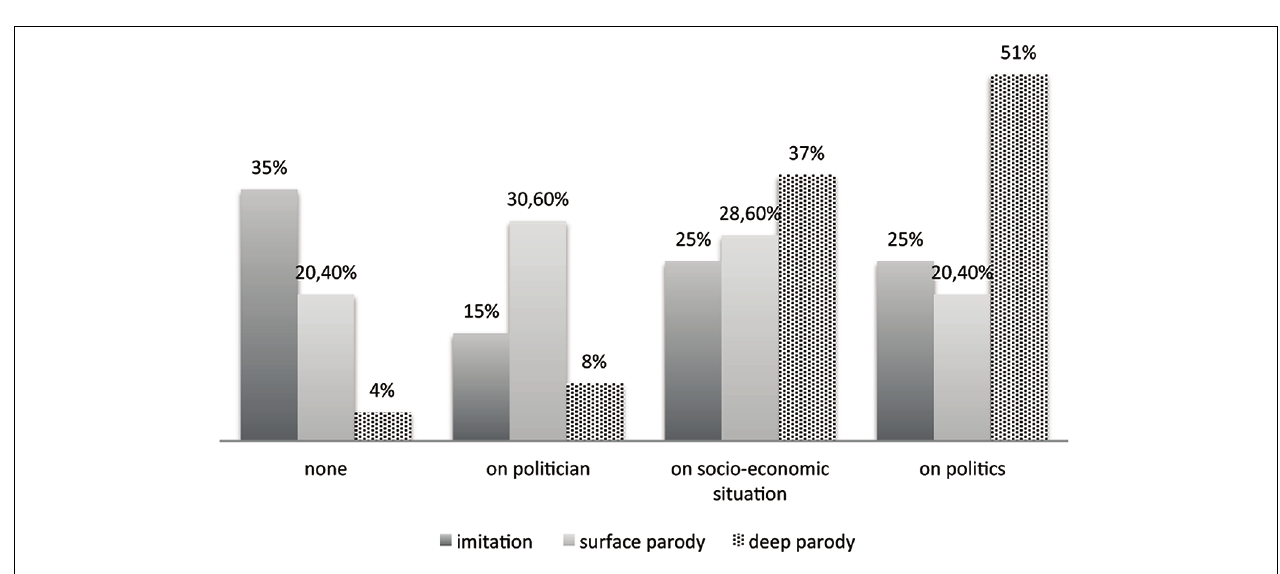
FIGURE 2 | Mediational regression analyses of indignation and negative evaluation of character’s benevolence on negative evaluation of real politician’s benevolence. ∗ p < 0.05; ∗∗ p < 0.01; ∗∗∗ p < 0.001. Solid lines between variables denote direct paths between two variables. Dotted lines denote paths when negative evaluation is included as mediator. Values denote standardized Beta weights.